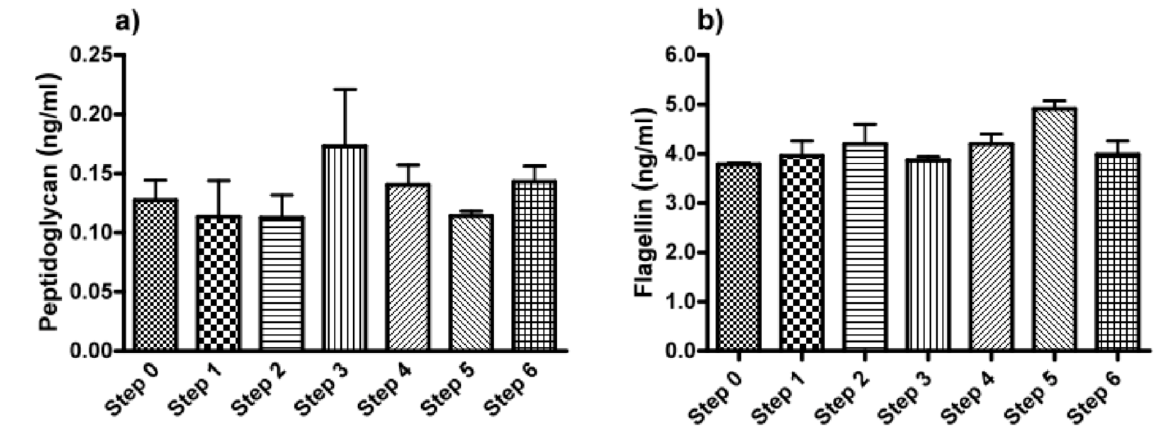
Figure 3. ( a ) Peptidoglycan and ( b ) flagellin concentration in the different purification